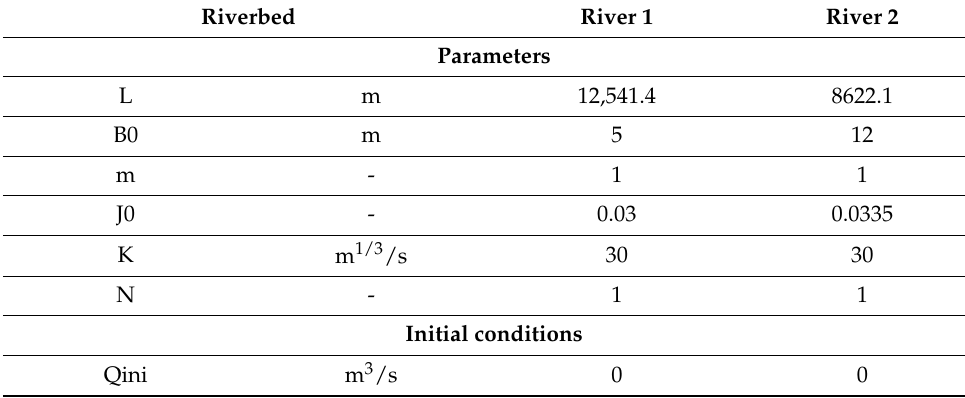
Table 9. Riverbed model parameters by cinematic